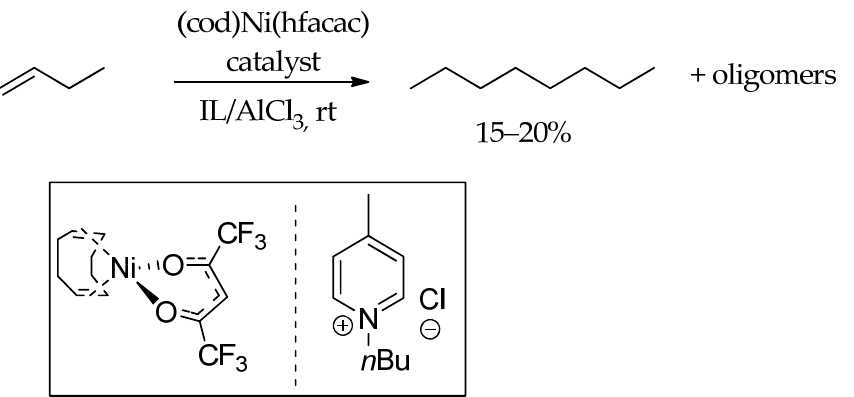
Scheme 31. Ionic liquids in a biphasic dimerization reaction